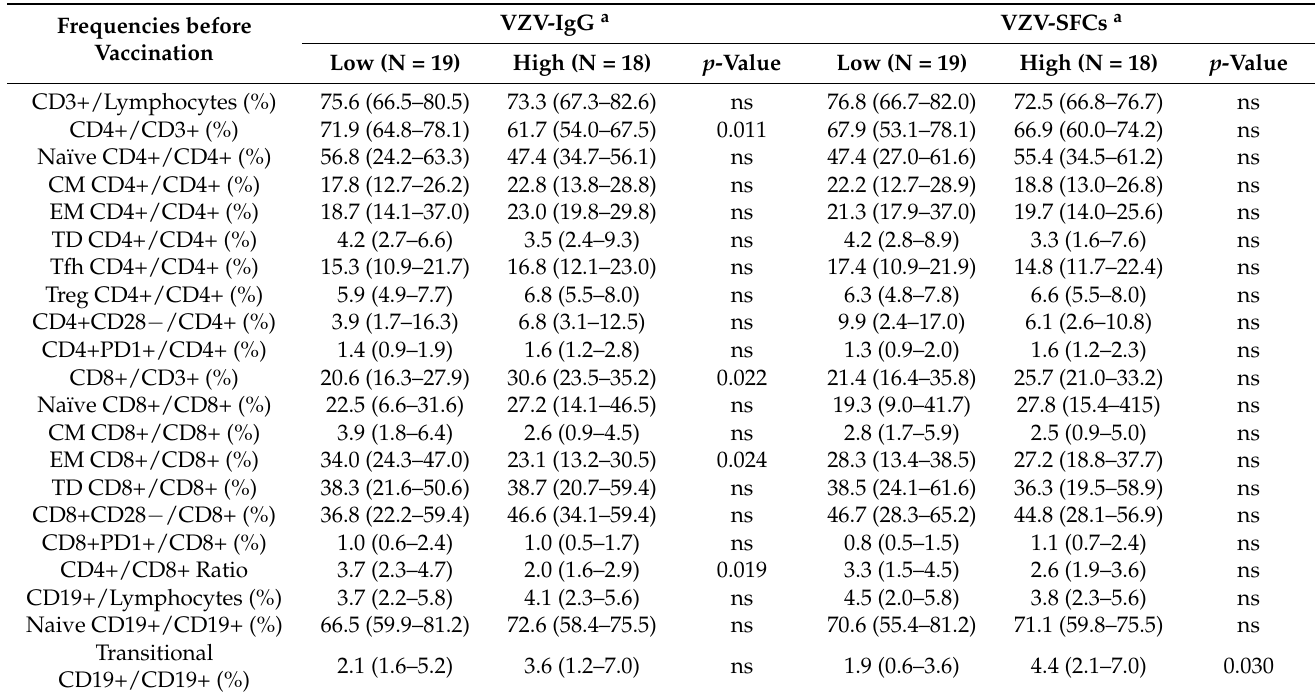
Table A2. Frequency of T/B cell subsets before vaccination in patients with low/high delta changes of VZV-IgG or VZV-SFCs. Frequencies before